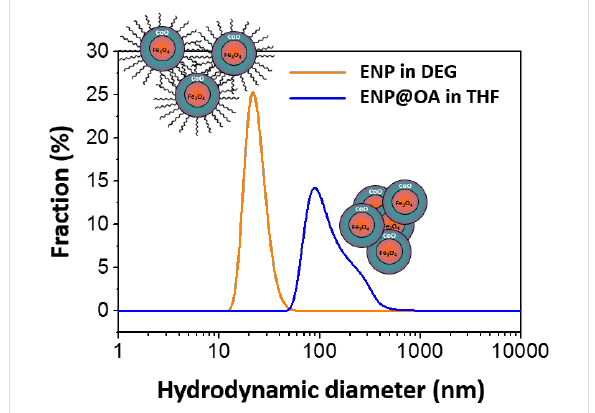
Figure 7: Size distributions of ENPs, in polyol solvent (diethylene glycol) and functionalized by oleic acid, dispersed in tetrahydrofuran solvent (THF), obtained by